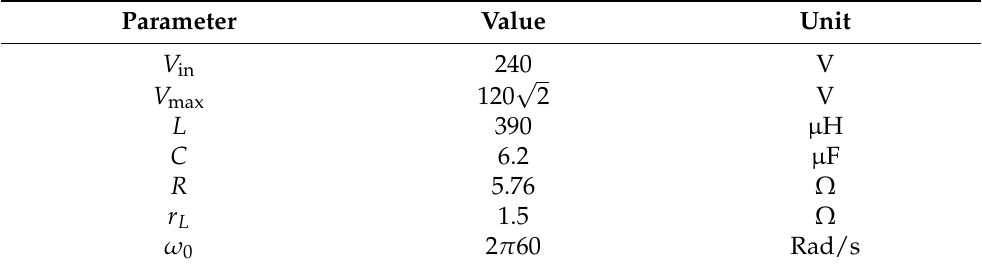
Table 1. Parameters of the full-bridge